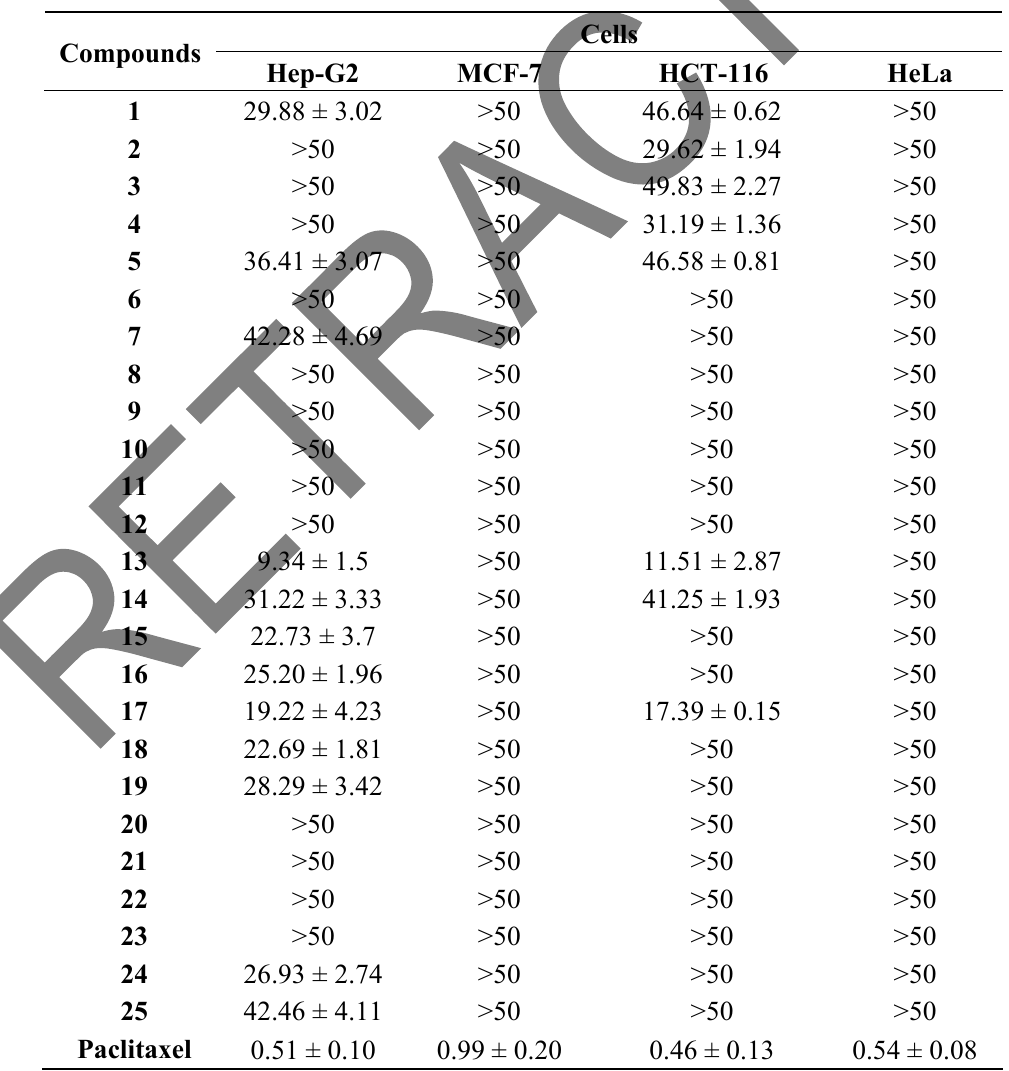
, µg/mL) of different tested compounds against human Table 1. Cytotoxicity (IC 50 malignant cell lines after 24 h of